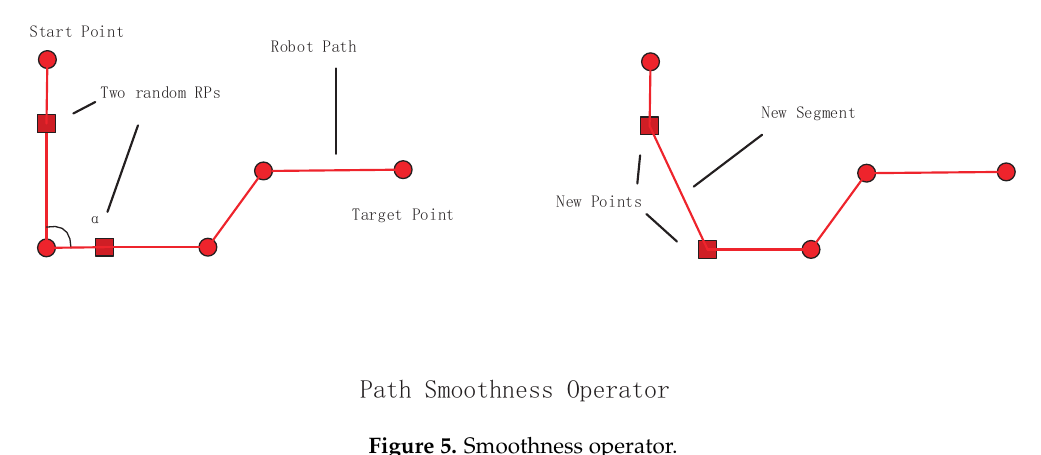
Figure 5. Smoothness operator.